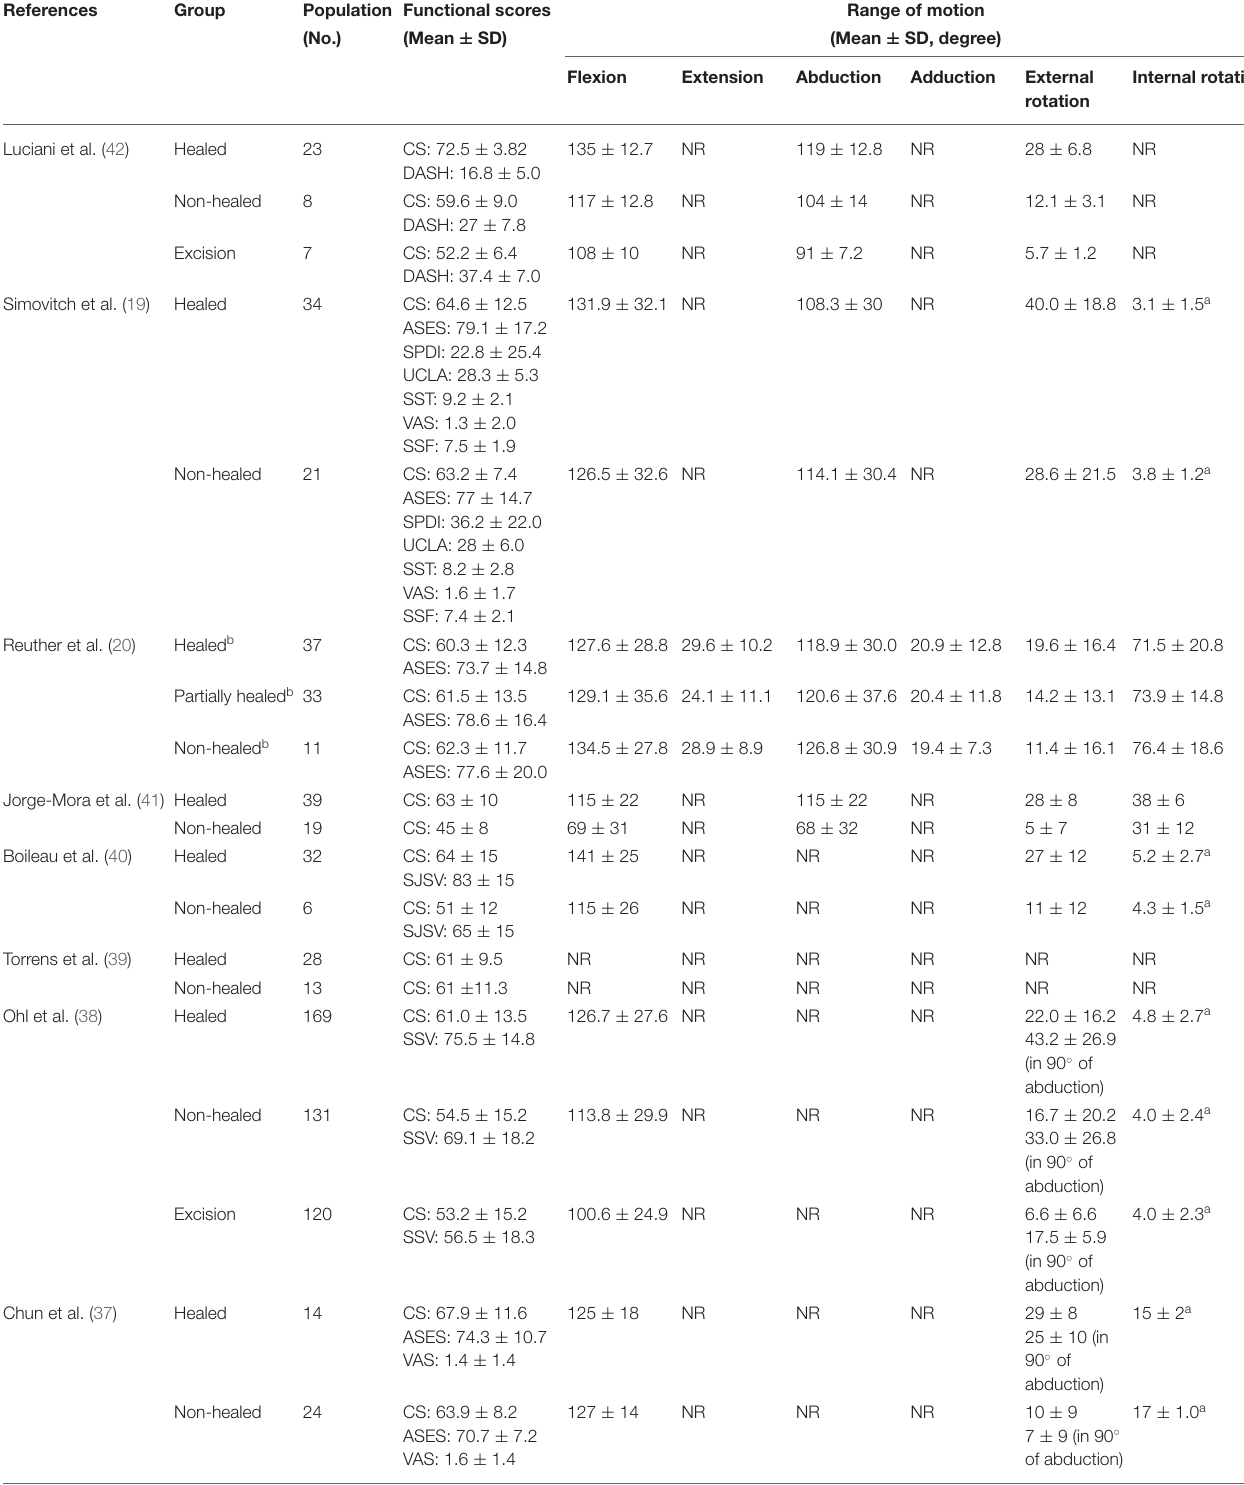
TABLE 2 | Summary of clinical outcomes of the included